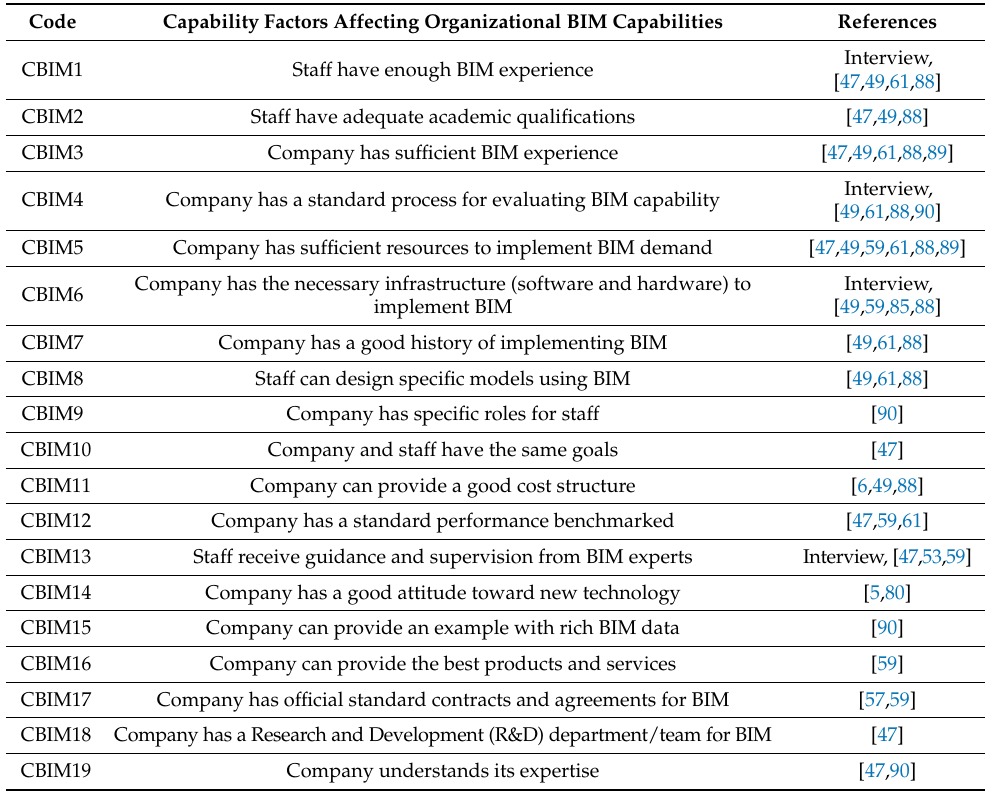
Table 2. List of capability factors affecting